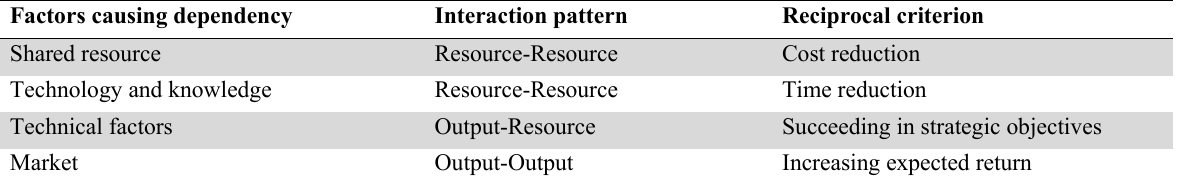
Factors causing dependency and reciprocal interaction patterns Factors causing dependency Interaction pattern Reciprocal criterion Shared resource Resource-Resource Cost reduction Technology and knowledge Resource-Resource Time reduction Technical factors Output-Resource Succeeding in strategic objectives Market Output-Output Increasing expected